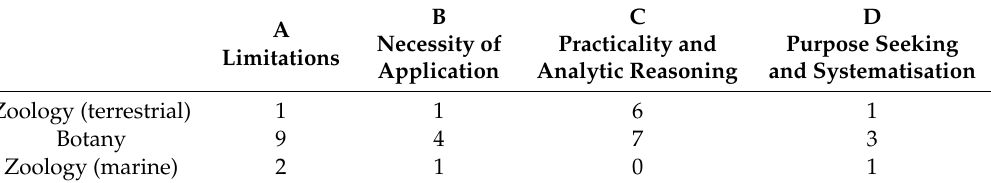
Table 2. Spread of codes based on field of